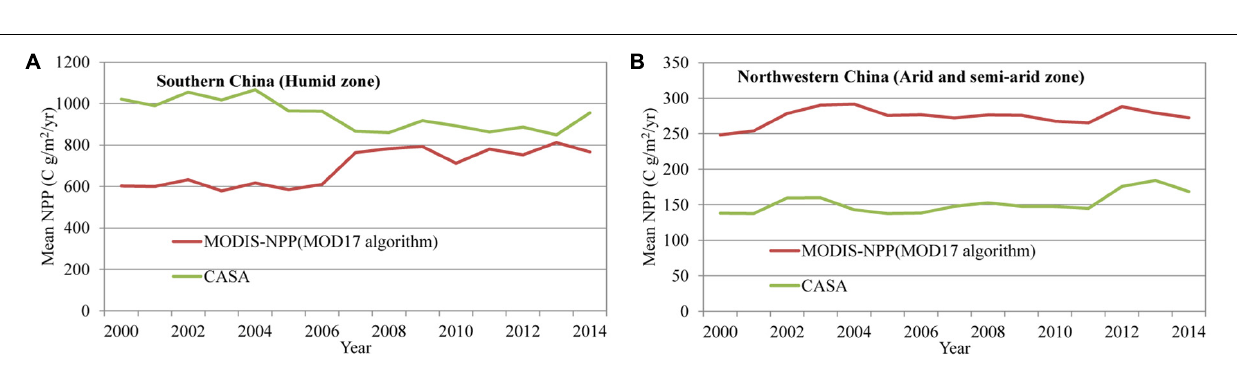
FIGURE 1 | The meteorological stations (red dots), carbon flux observation station (green triangles), and our study area including the DEM in color shades.